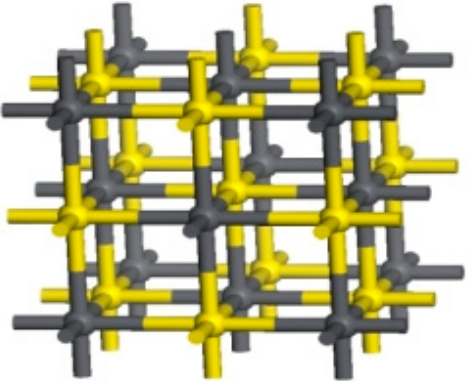
Figure 1. Crystal structure of perfect galena (Yellow: S atoms; Gray: Pb atoms).